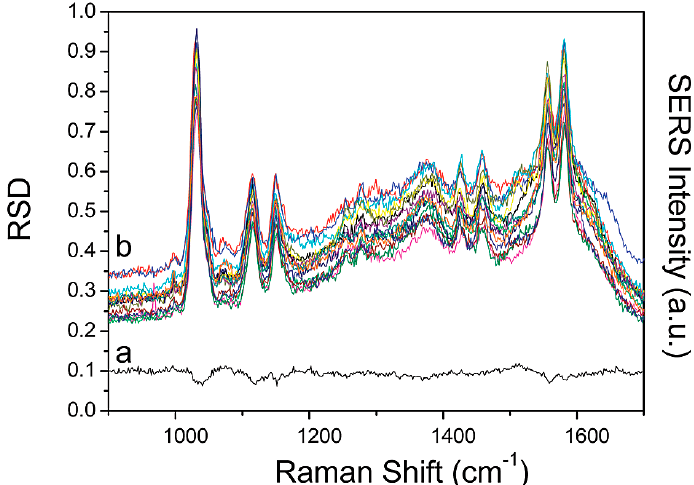
Figure 11. RSD-SERS graph. ( a ) RSD value curve of SERS of 10 − 6 M 4-MBA collected on the randomly selected 15 places on the Ag / PVA nanofiber mat. ( b ) Series of SERS spectra collected from the randomly selected 15 places on the Ag / PVA nanofiber mat [160]. Reprinted from the ACS Nano, Vol 3, Xianfeng Wang, Dian He, Bo HuQiao-Feng, YaoKan Wang, and Shu-Hong Yu, Large-Scale synthesis of flexible free-Standing SERS substrates with high sensitivity: Electrospun PVA nanofibers embedded with controlled alignment of silver nanoparticles, 3993–4002., Copyright (2009) with permission from American Chemical Society. Sensors 2019 , 19 , x